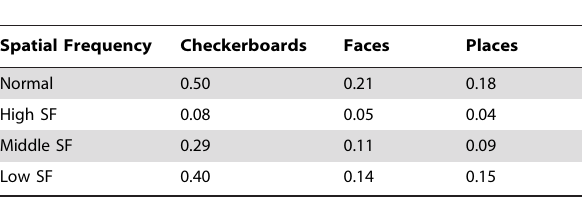
Table 1. The root mean square contrast of SF-filtered